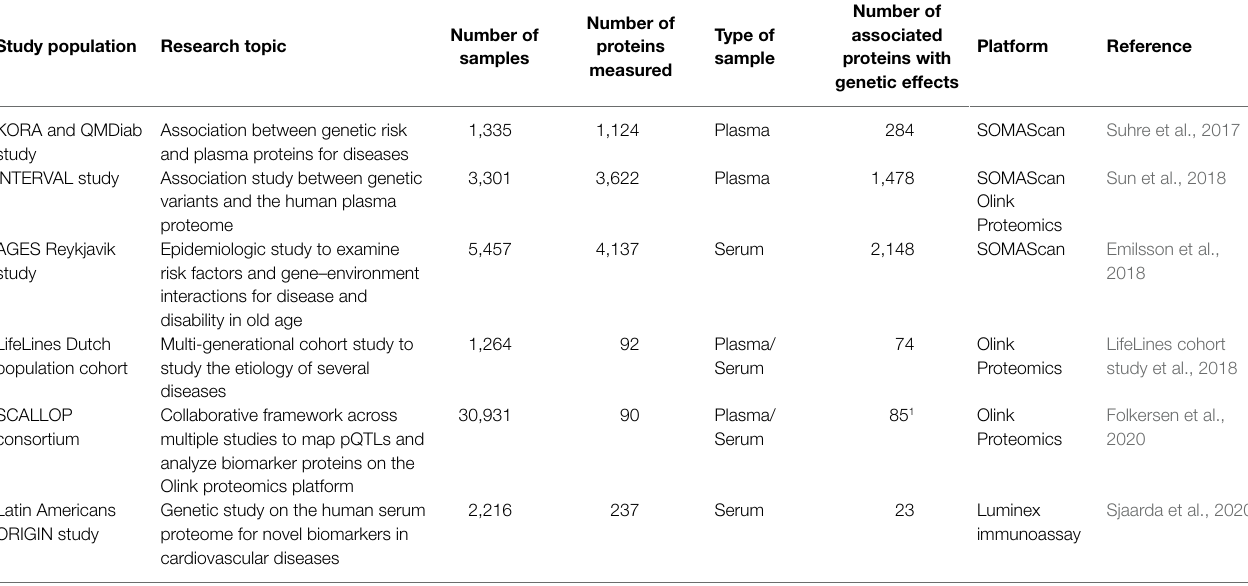
TABLE 1 | Summary of large-scale population cohorts with quantitative proteomics